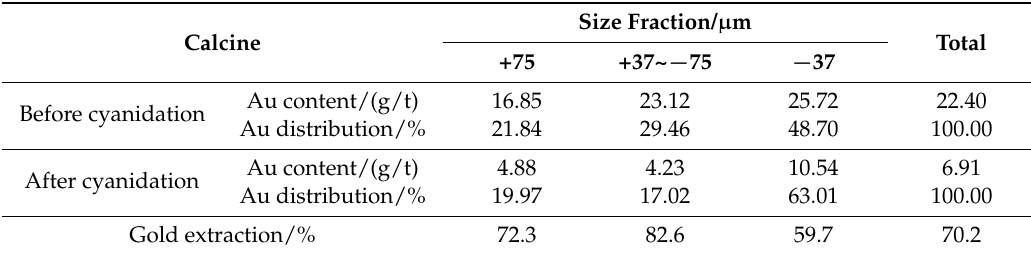
Table 3. Results of gold leaching from the different size fractions of